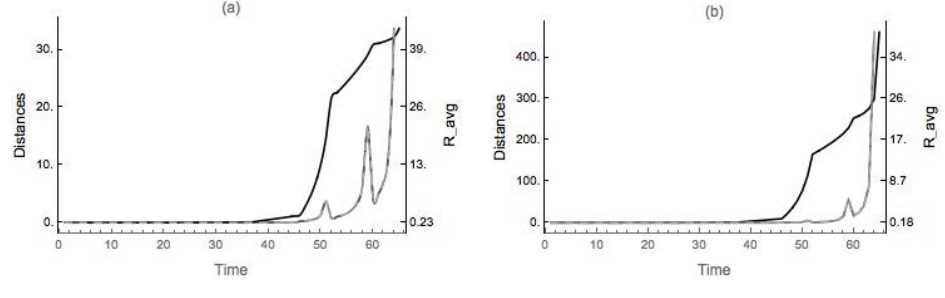
Figure 9. β 0 : Interpolation functions of average scalar curvature (denoted by R_avg, solid black line), bottleneck (gray), Wasserstein-1 (dark gray, dashed), and Wasserstein-2 (light gray, dashed) distances for ( a ) Nx = 50 and ( b ) Nx = 100